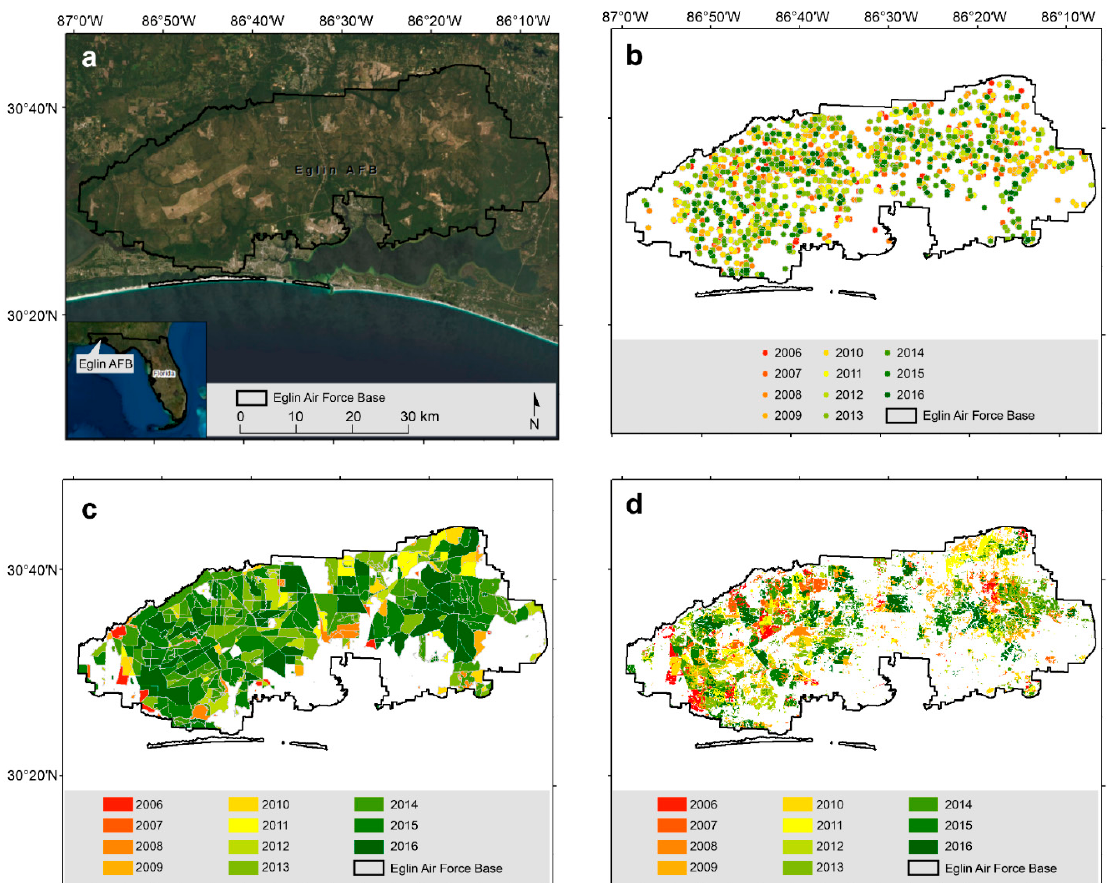
Figure 3. Displaying the fire history using different data sources results in different mapping outputs for ( a ) Eglin Air Force Base (EAFB), Florida. ( b ) Florida Forest Service Open Burn Authorization data for the period 2006–2016 partially depict the amount of burn authorizations requested but not an exact location; ( c ) landowner-provided fire history data illustrate when fire was applied to a burn unit; ( d ) fire extents derived by thresholding the Landsat burn probability ( ≥ 90%) showing when and where a fire was detected, including the mosaic within a burn unit.